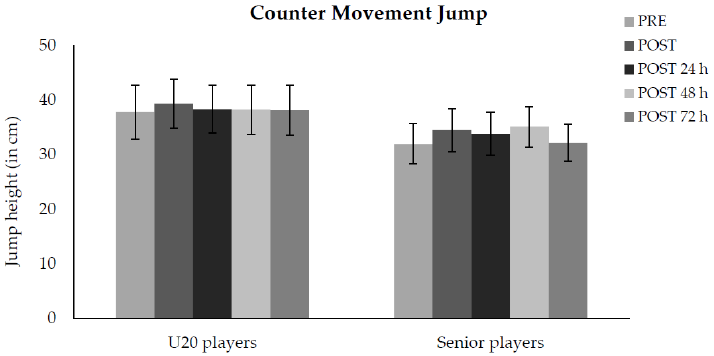
Figure 2. Mean jump height (in cm) as a function of measurement time point (PRE, POST, POST 24 h, POST 48 h, POST 72 h) for U20 and senior handball players. The error bars represent standard deviations.